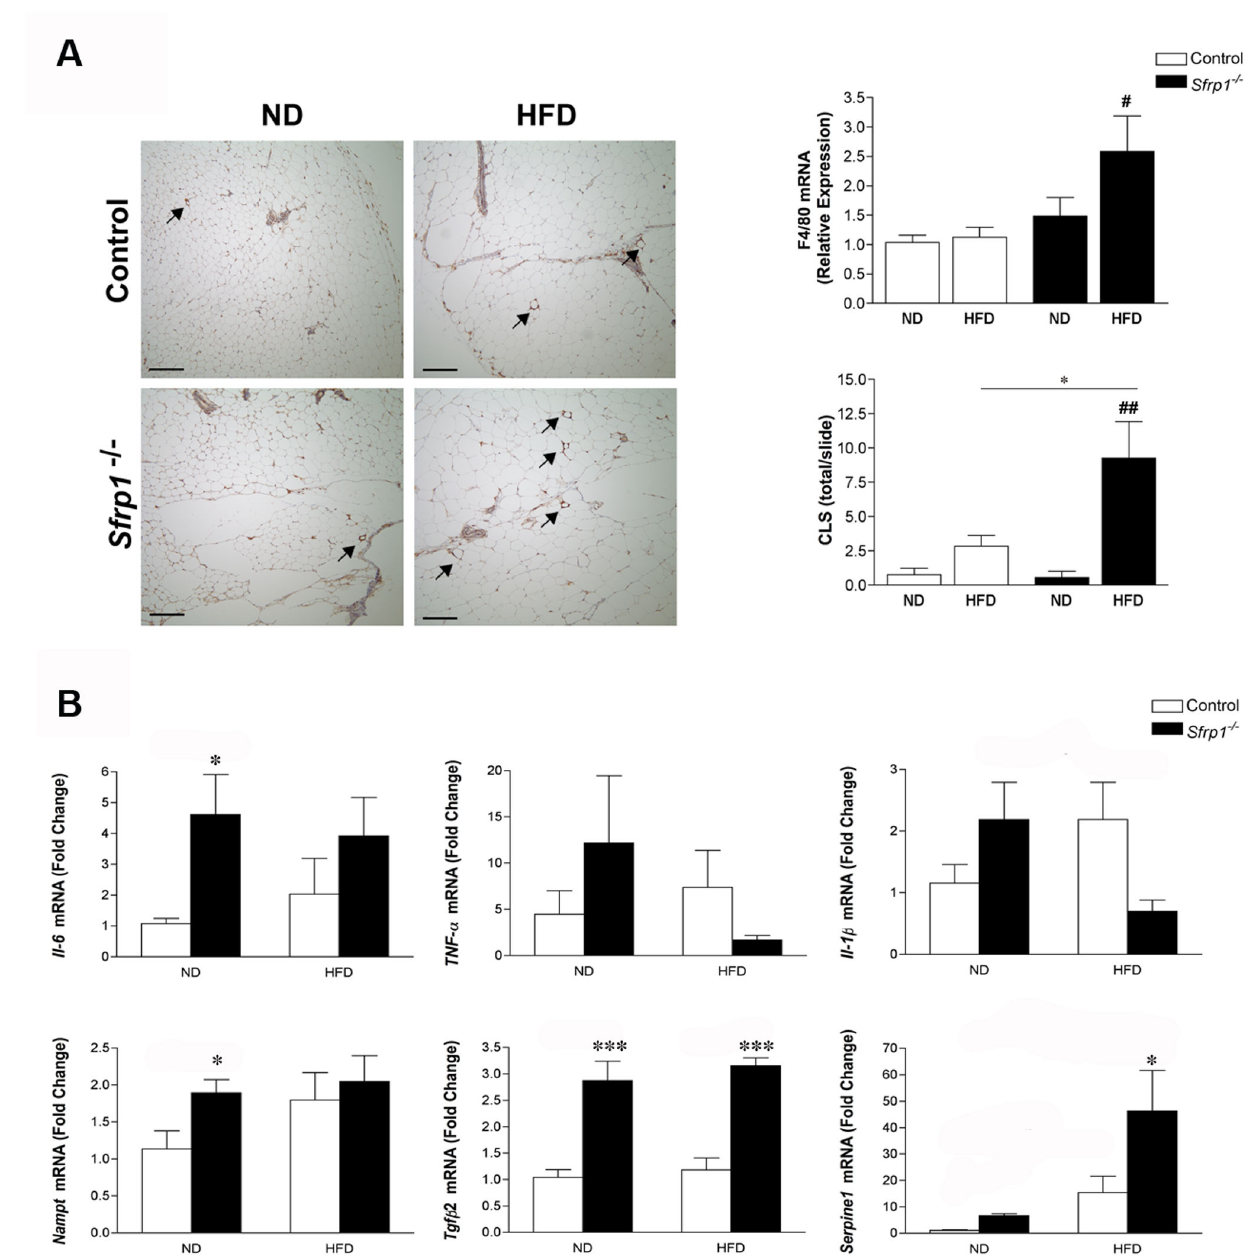
Figure 5. Macrophage infiltration and cytokine expression in the mammary gland. Left panel , 3 rd & 4 th inguinal mammary gland sections were subjected to immunohistochemical analysis, stained for F4/80 (brown chromogen), and representative images were captured at 100X are displayed for mice in each treatment group (scale bar 200 μm). Right upper panel , total RNA was harvested from 5 th inguinal mammary glands and employed for real-time PCR analysis of F4/80 mRNA, experiments were carried out as described, and bars represent mean ± SEM of the relative expression with respect to ND fed mice. Right lower panel , The total number of CLSs (see arrow inset) were counted in F4/80 stained mammary gland sections (n=4/treatment group) (D) Real-time PCR analysis of liver Il-6 , Tnf -α, Il-1β, Nampt, Tgf -β2, and Serpine 1 gene expression was carried out as described above. Bars represent mean ± SEM of the difference in fold change compared with control ND fed mice. (*p<0.05, ***p<0.001 significantly different from control mice fed a ND using Bonferroni’s t test after a two-way ANOVA; # p<0.05, ## p<0.01, significantly different from respective ND fed mice using student’s t test.).